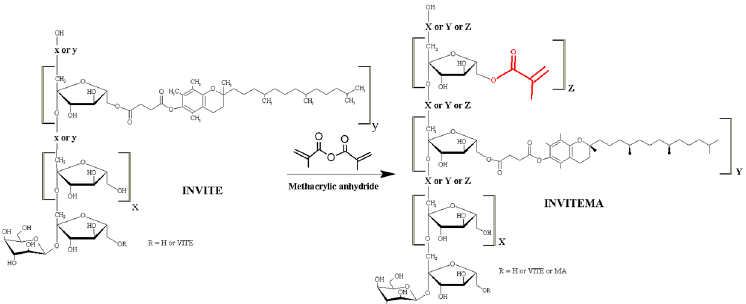
Figure 1. Scheme of reaction between inulin-vitamin E (INVITE) and methacrylic anhydride (MA) leading to INVITEMA conjugate. Table 1. Reaction conditions for the synthesis of INVITEMA conjugates, their nomenclature, molar